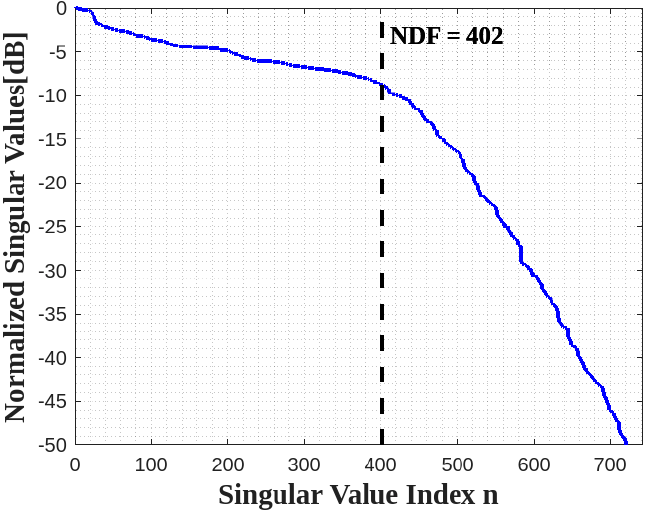
Figure 6. The behavior of normalized singular values for two parallel XY faces.